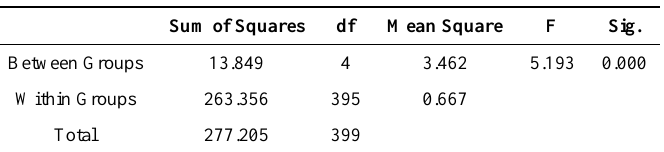
Table 12. ANOVA results